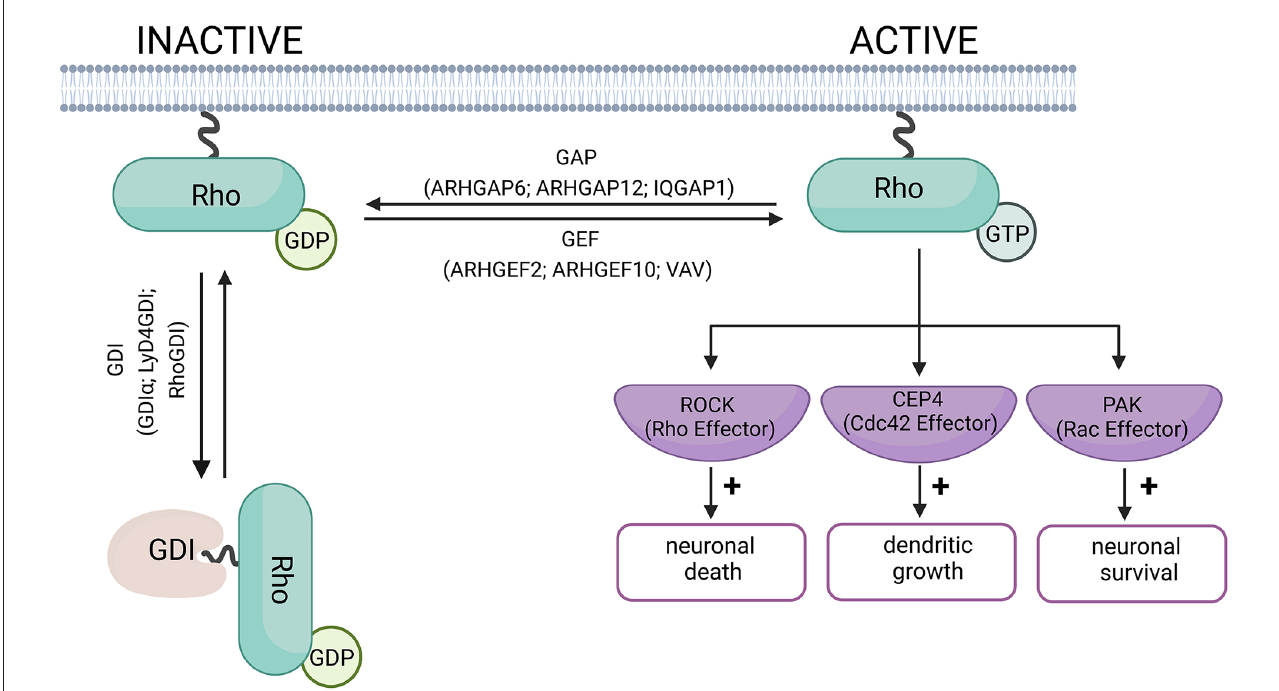
FIGURE1 Schematic diagram of Rho-GTPase activation and inactivation. When Rho-GTPase is bound to GDP, it remains in its inactive form. Rho-GEF proteins mediate the switch from GDP to GTP, and activate the Rho-GTPase. Rho-GAP proteins hydrolyze the Rho-bound GTP to GDP, allowing the Rho-GTPase to return to its inactive form. The role of the GDI proteins is to prevent the exchange of GDP for GTP and keep the Rho-GTPase in its inactive form (Bos et al., 2007; Garcia-Mata et al., 2011). The examples of GEF and GAP proteins have been linked to neurodegenerative disorders and are discussed in this review. Examples of effector proteins and the cellular responses they mediate include Cdc42 effector protein-4, which promotes dendritic growth in neurons (Hou et al., 2022). Rho-induced ROCK activation can promote neuronal death, while Rac promotes neuronal survival (Stankiewicz and Linseman, 2014). Created with